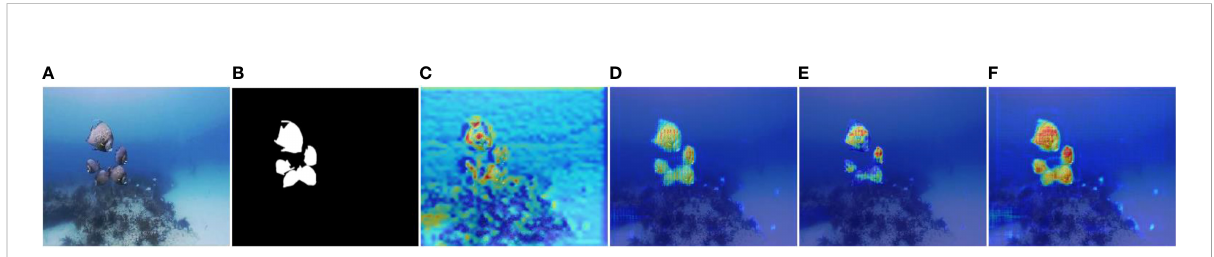
FIGURE 12 Visual depiction of progressive learning by MFAS-Net using activation maps taken from different stages of the architecture. (A) original image. (B) Ground truth image. Heat activation maps are obtained from the (C) ReLU 2, (D) ReLU 6-SP, (E) ReLU 8, and (F) ReLU 12 layers of the MFAS- Net, as given in Table 1.